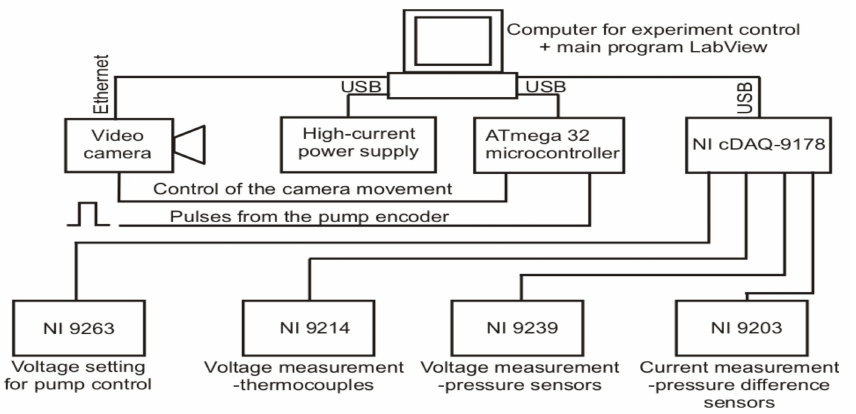
Figure 4. Block diagram of the data flow and control system.